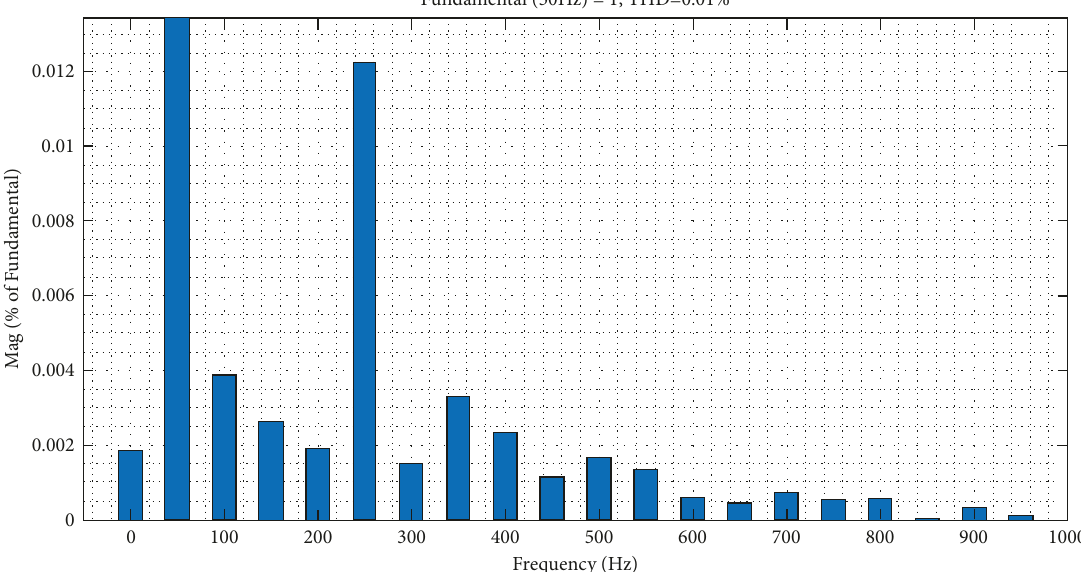
Figure 17: THD (voltage) for FIS and ANFIS with level shift